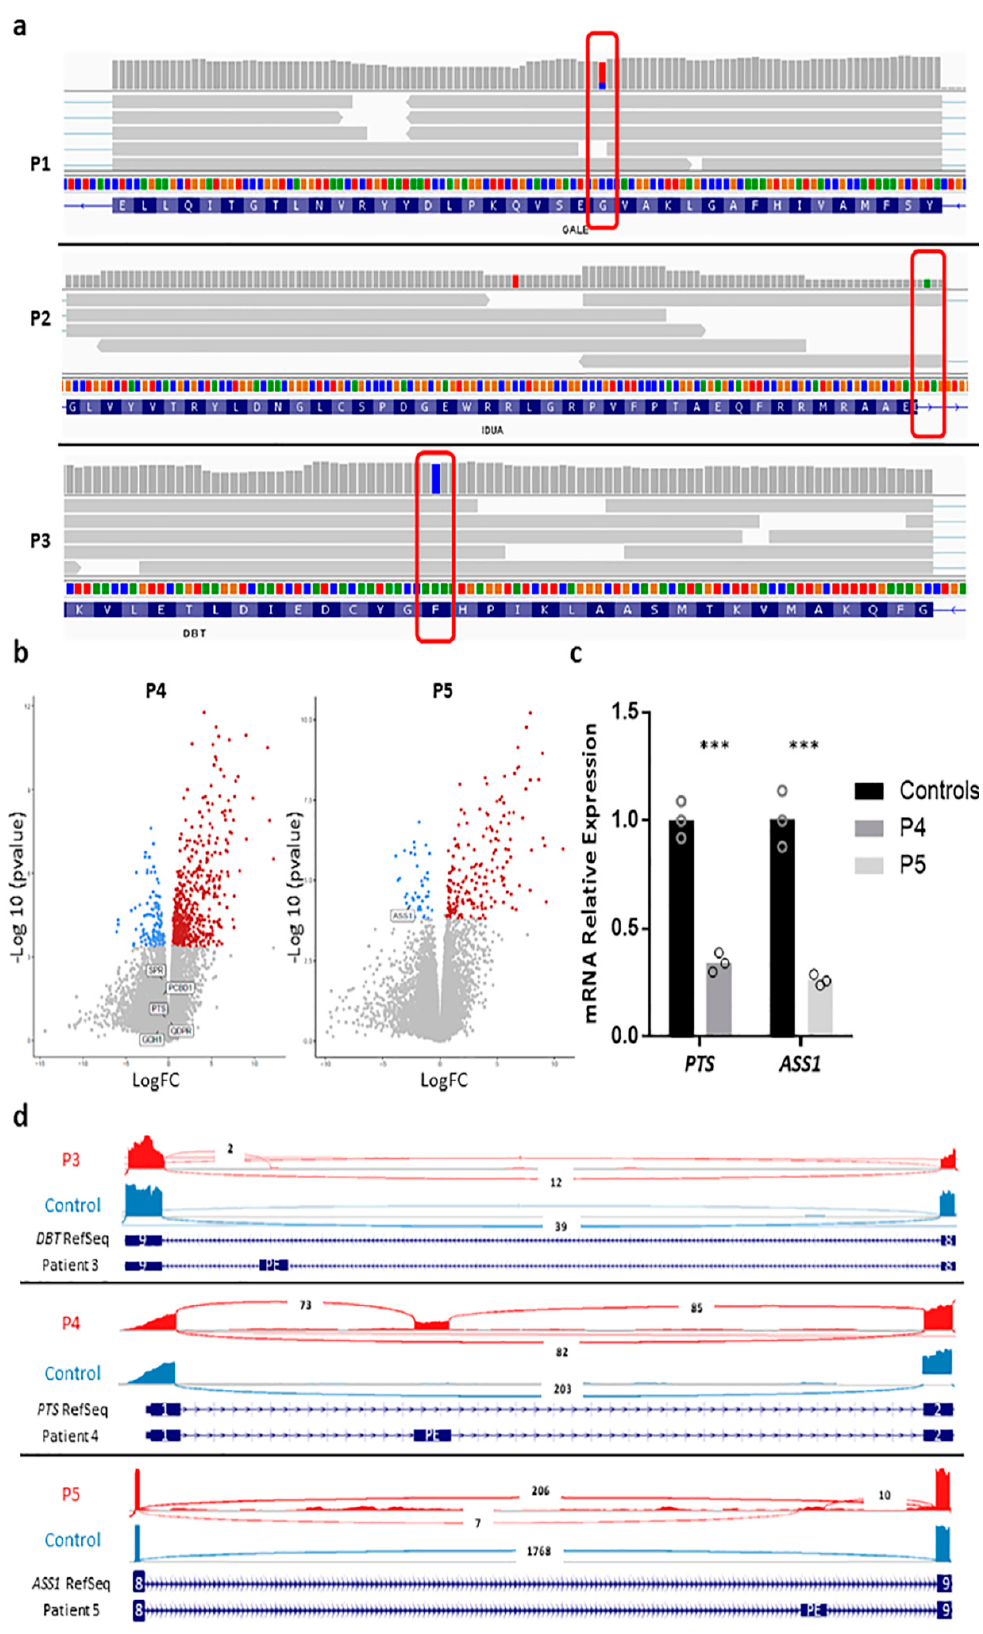
Figure 1. RNA-Seq analysis. ( a ) RNA-Seq reads mapped onto the GALE gene in P1 (top panel); variant c.284G>A is marked in a red rectangle. The wild-type sequence is shown in blue (14%)